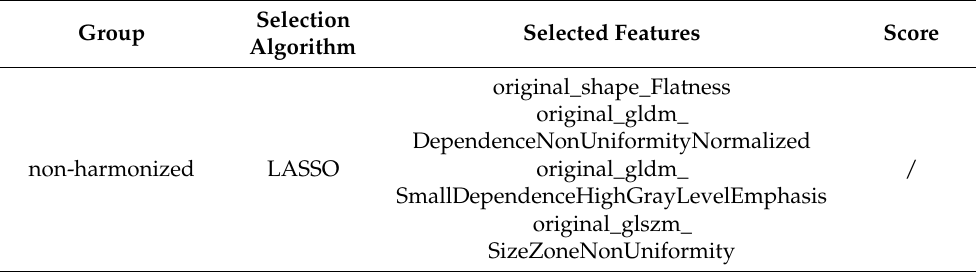
Selected Features